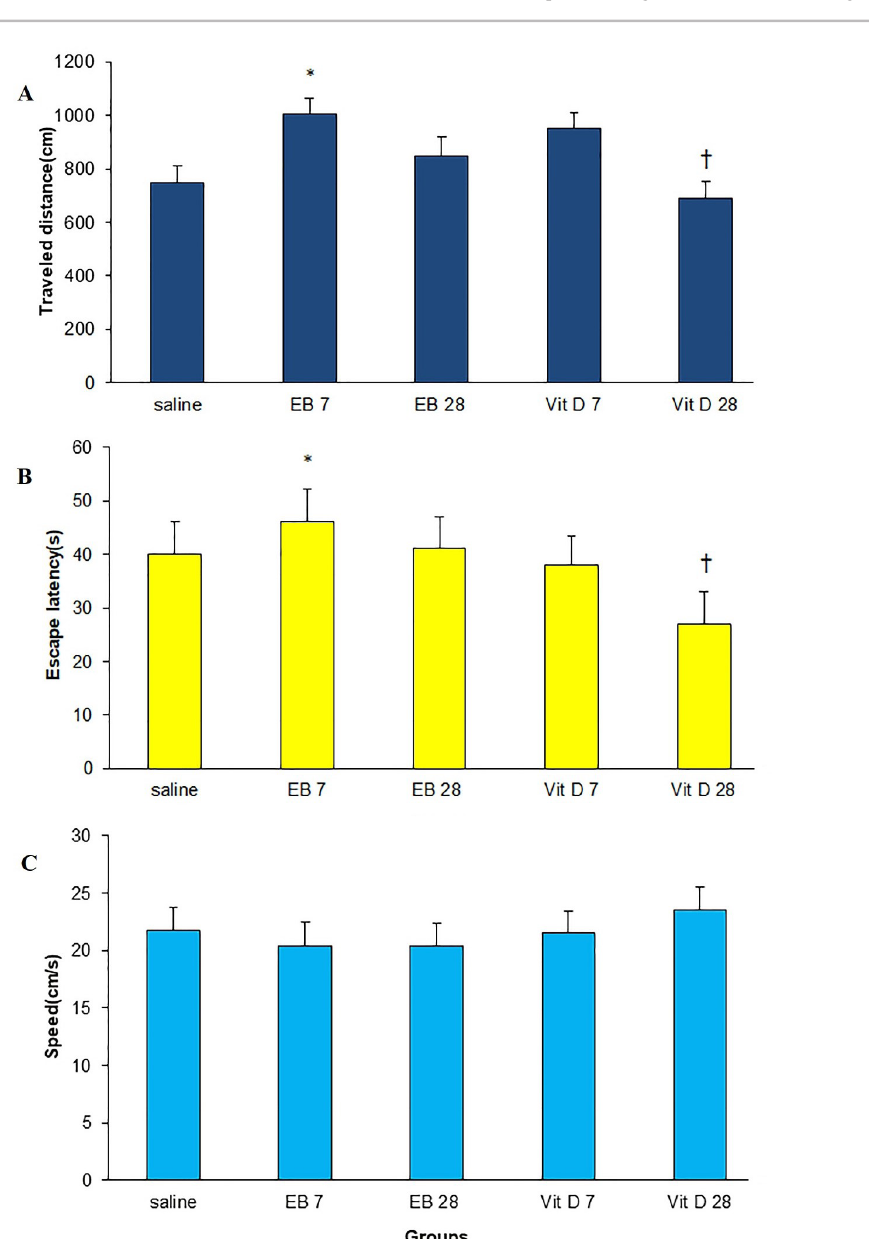
FIGURE 1 - Effects of vitamin D on spatial memory after 28 days of EB injection. A: Effect on traveled distance B: Effect on 3 escape latency to find the platform C: Effect on swimming speed to assure normal locomotor activity. Each data is average of 10 experiments and bars represent standard errors. *,†: p <0.05 significant difference between EB 7 and Vitamin D 28